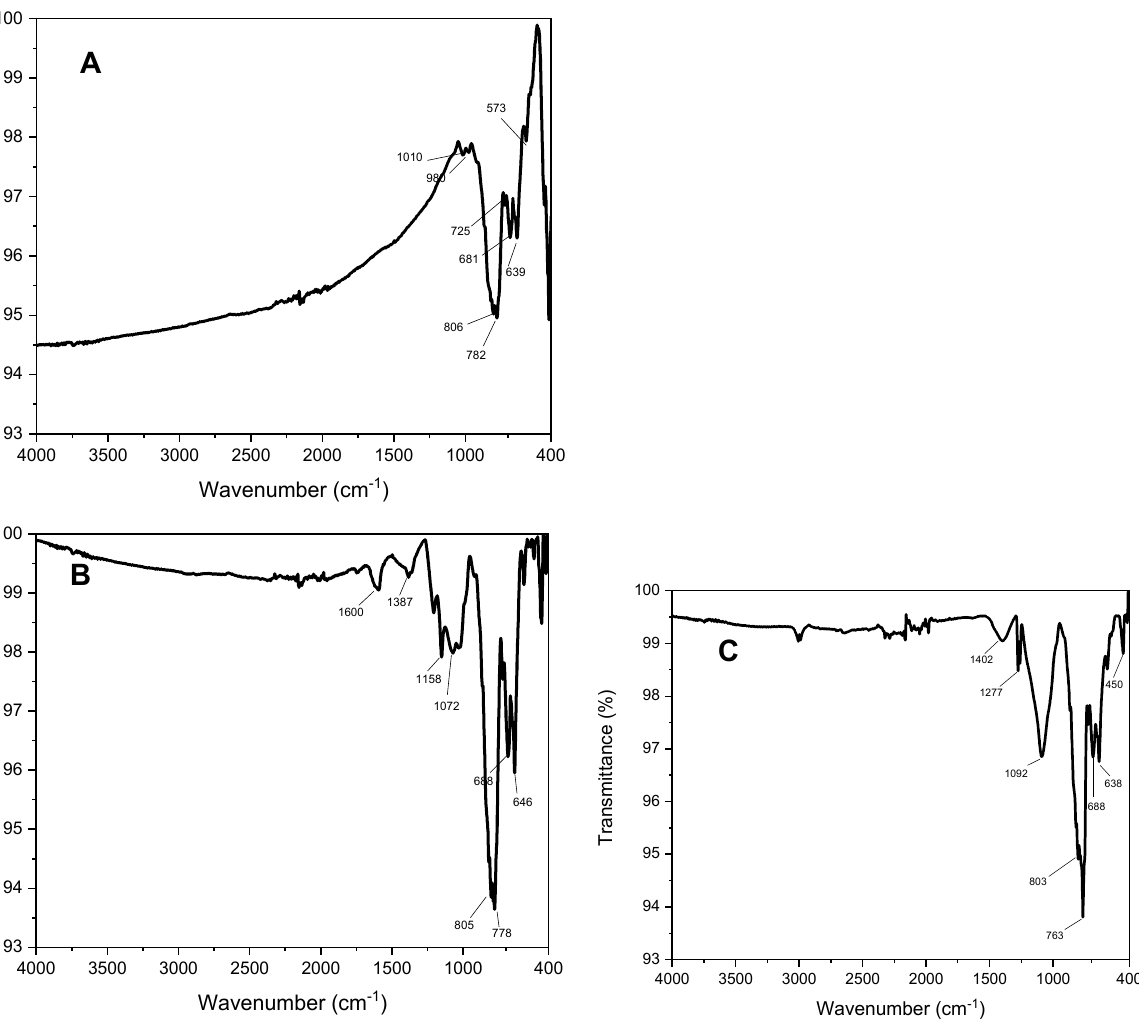
Figure 3 . ATR − FTIR spectrum of catalyst 1 ( A ) as-prepared, ( B ) after fourth cycle, and ( C ) after fourth cycle and thermal treatment at 400 °C.